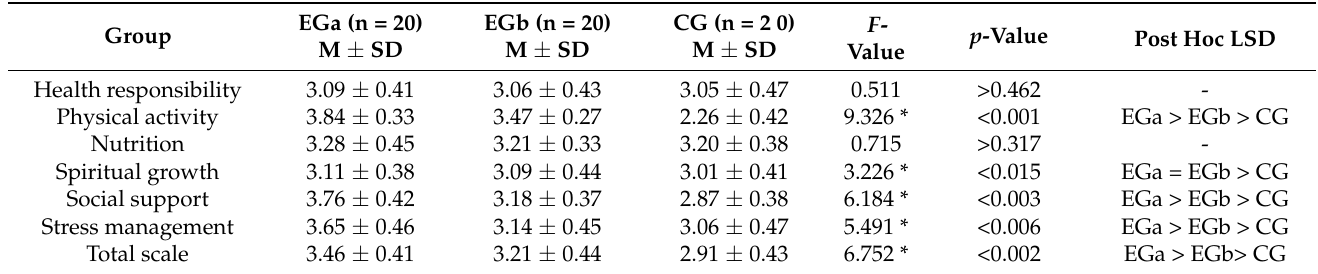
Table 6. Descriptive statistics. One-way ANOVA and LSD post hoc test for the Health-Promoting Lifestyle Profile Scale.